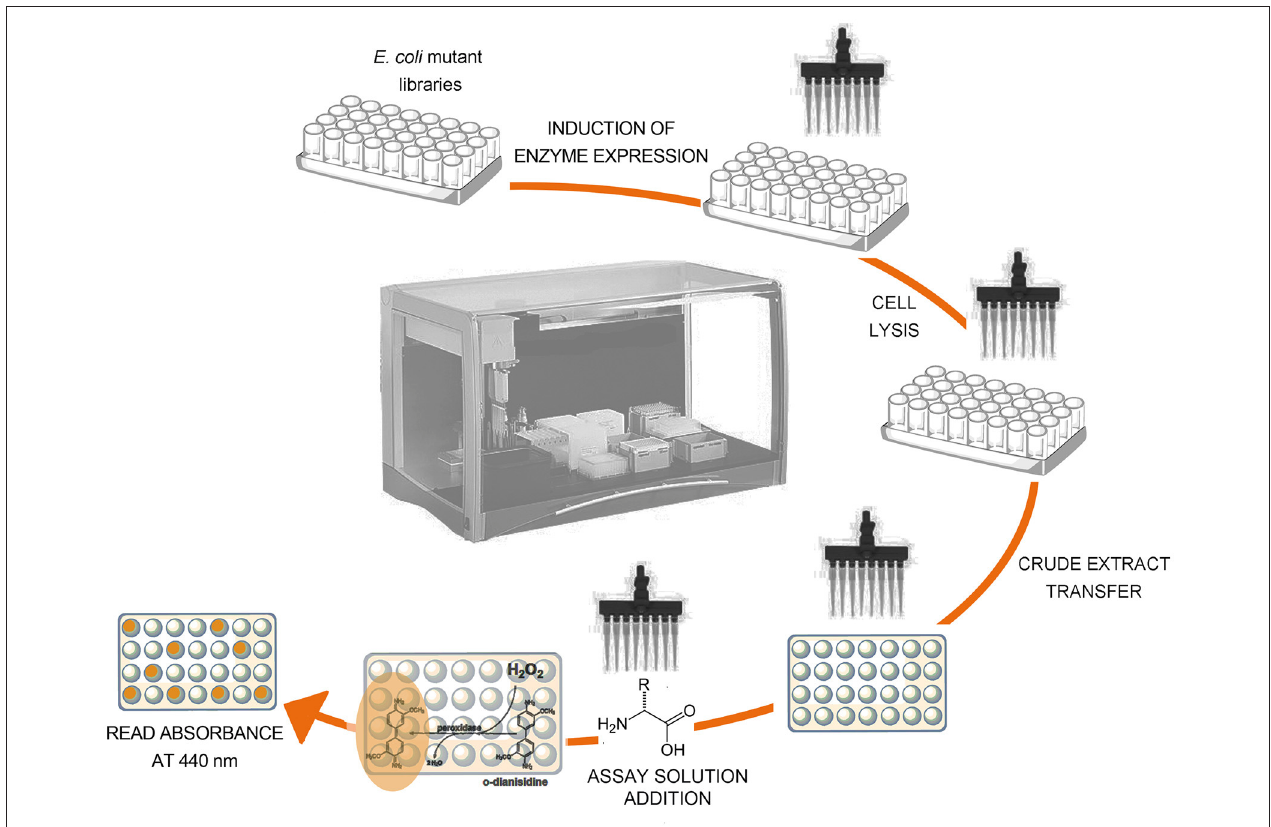
FIGURE 6 | Schematic representation of the screening procedure on crude extract of E. coli cells expressing RgDAAO variants.